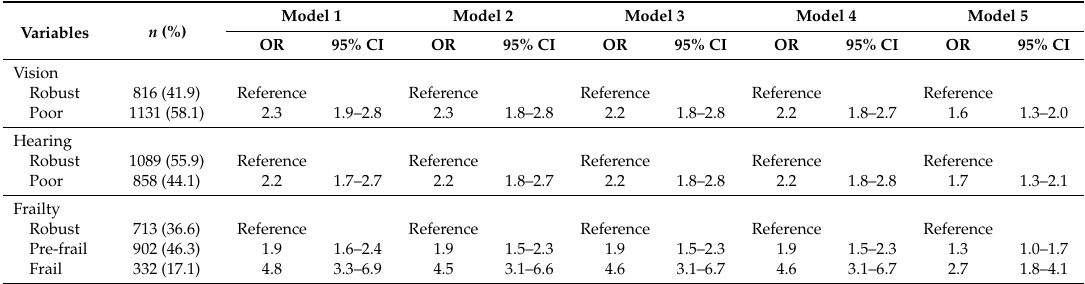
Figure 1. Flow chart of participants. Table 3. Associations of sensory impairment and frailty with subjective memory complaints (SMCs) after 12 months ( n = 1947).